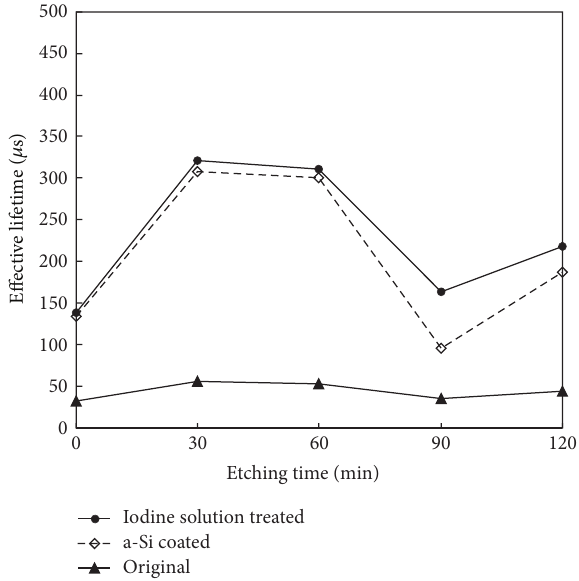
Figure 2: Effective minority carrier lifetime of wafers with different etching time and different passivation